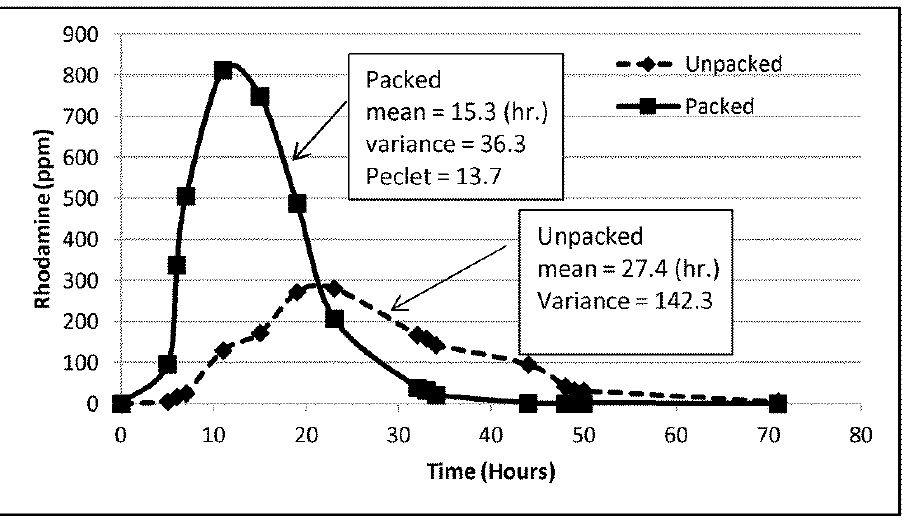
Figure 4. Toluene degradation results for packed